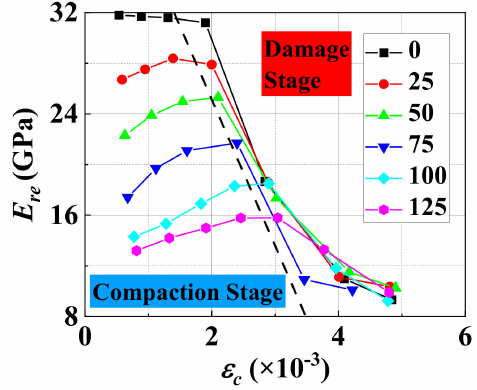
Figure 7. Relationship between reloading modulus and strain.